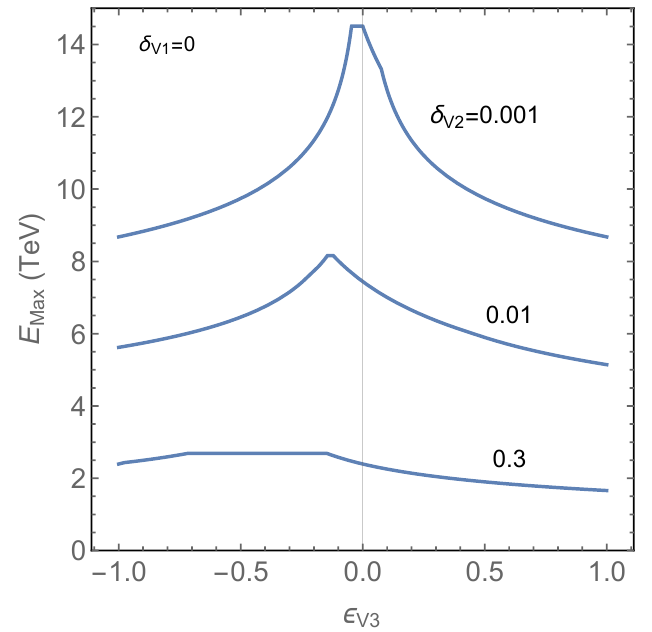
Figure 14 . The unitarity bound from processes that depend on δ V 2 and c V 3 = 8 δ V 2 (1 + (cid:15) V 3 ) to linear order, where (cid:15) = 0 correspond to the SMEFT predictions, assuming δ V 3